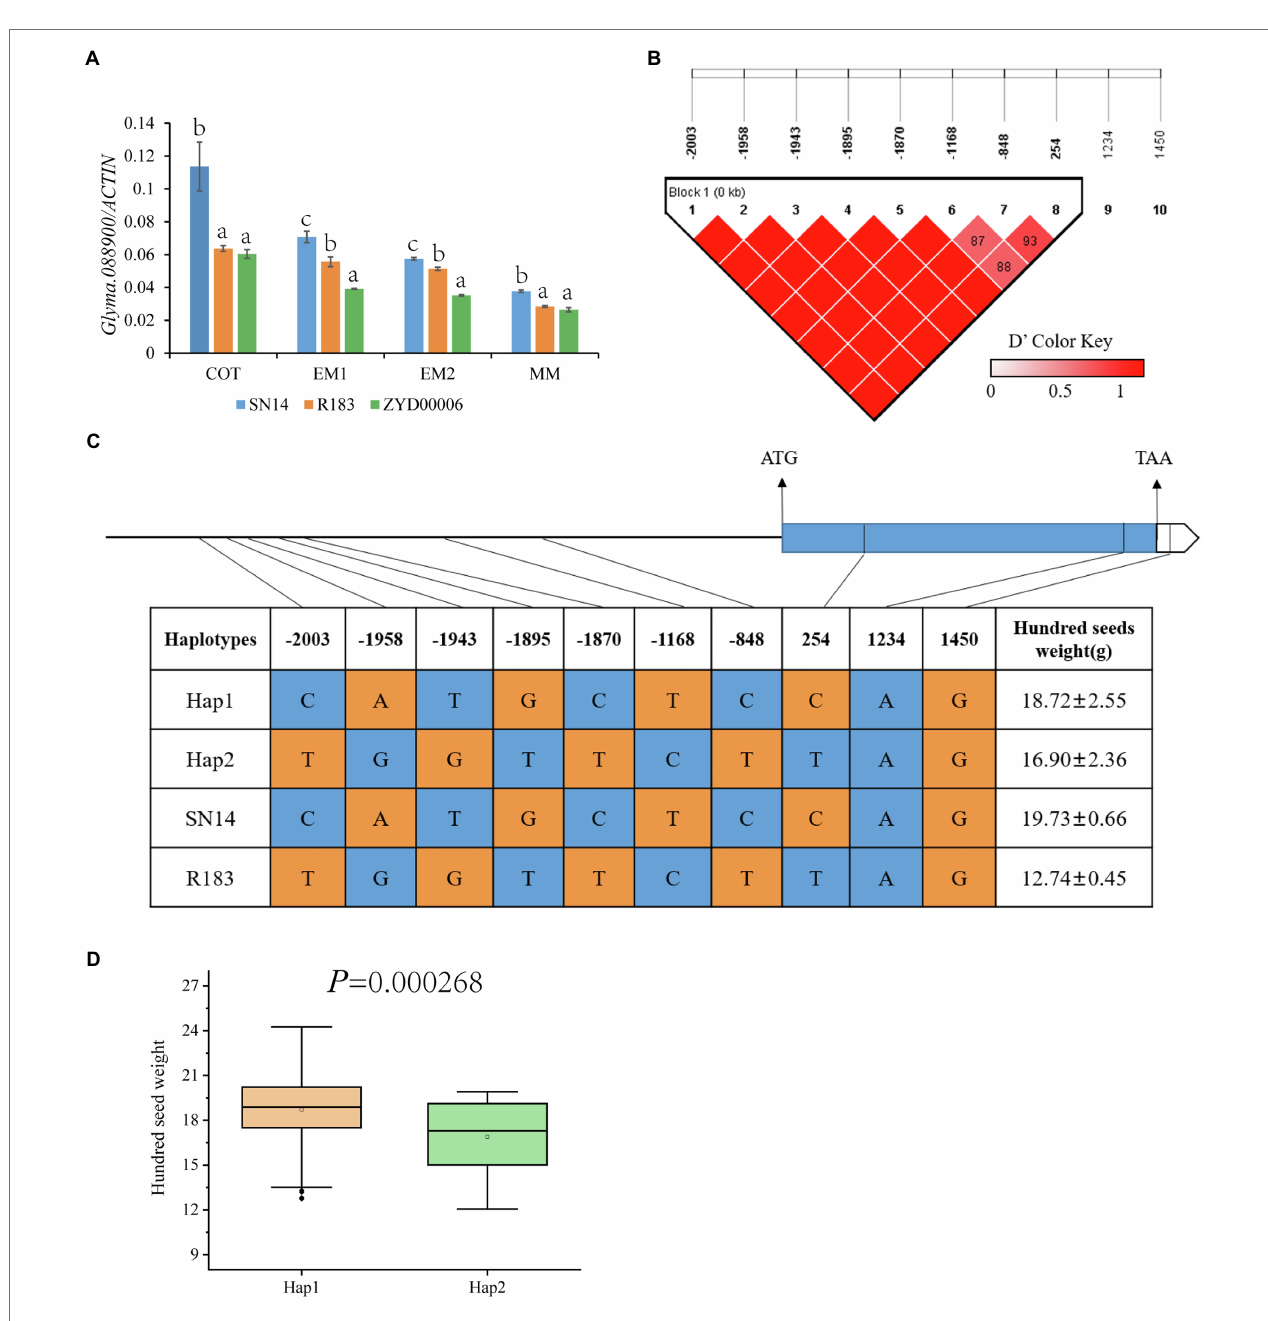
FIGURE 7 | Inferred candidate gene. (A) The relative expression of Glyma.12G088900 in SN14, ZYD00006 and R183 was determined by qRT-PCR. (B) LD analysis of SNPs located on Glyma.12G088900 . (C) Haplotype analysis of Glyma.12G088900 from 129 soybean resource. (D) The hundred-seed weight (HSW) of Hap1 and Hap2. a, b, c: Different letters represent significant differences between each other at the 0.05